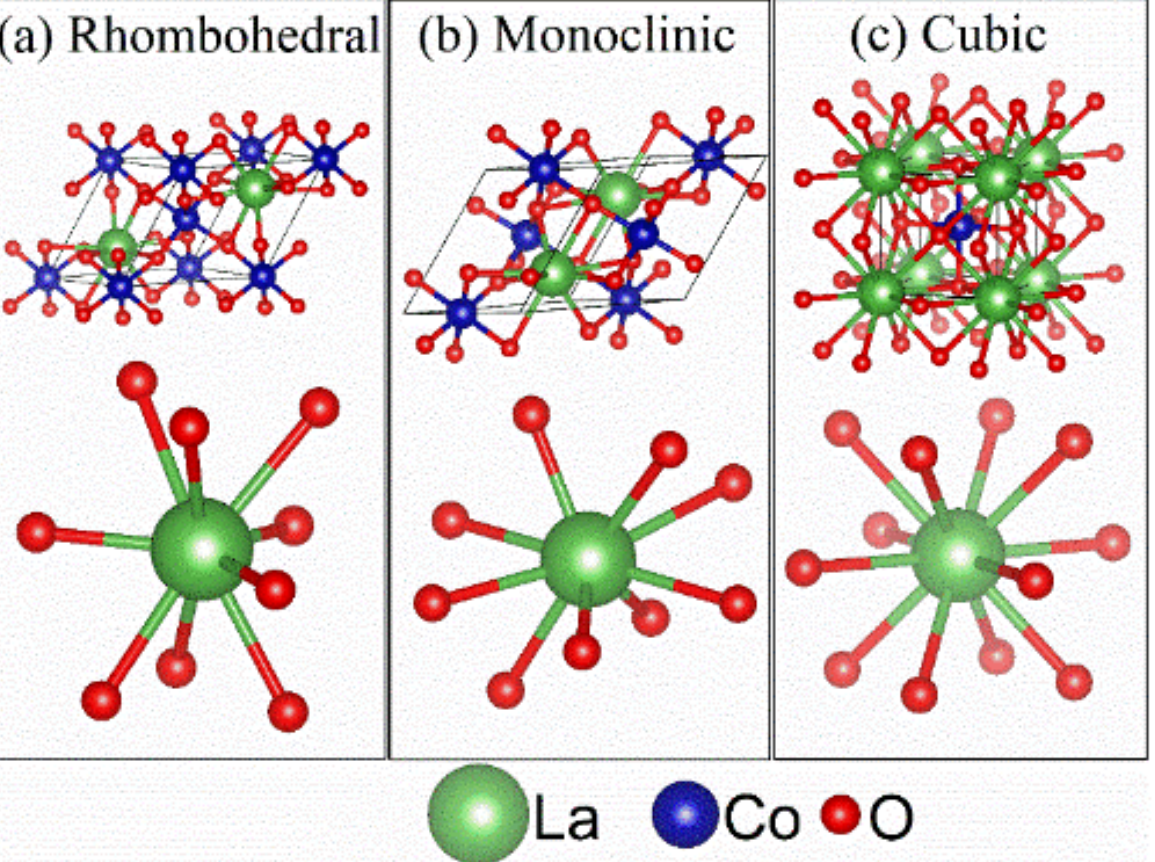
Figure 7. Schematic of the primitive cell of different models for the main phase of La 1 − x Ce x CoO 3 as ( a ) rhombohedral, ( b ) monoclinic, and ( c ) cubic, and local coordination geometry around La atoms showing the difference in the effective coordination number.